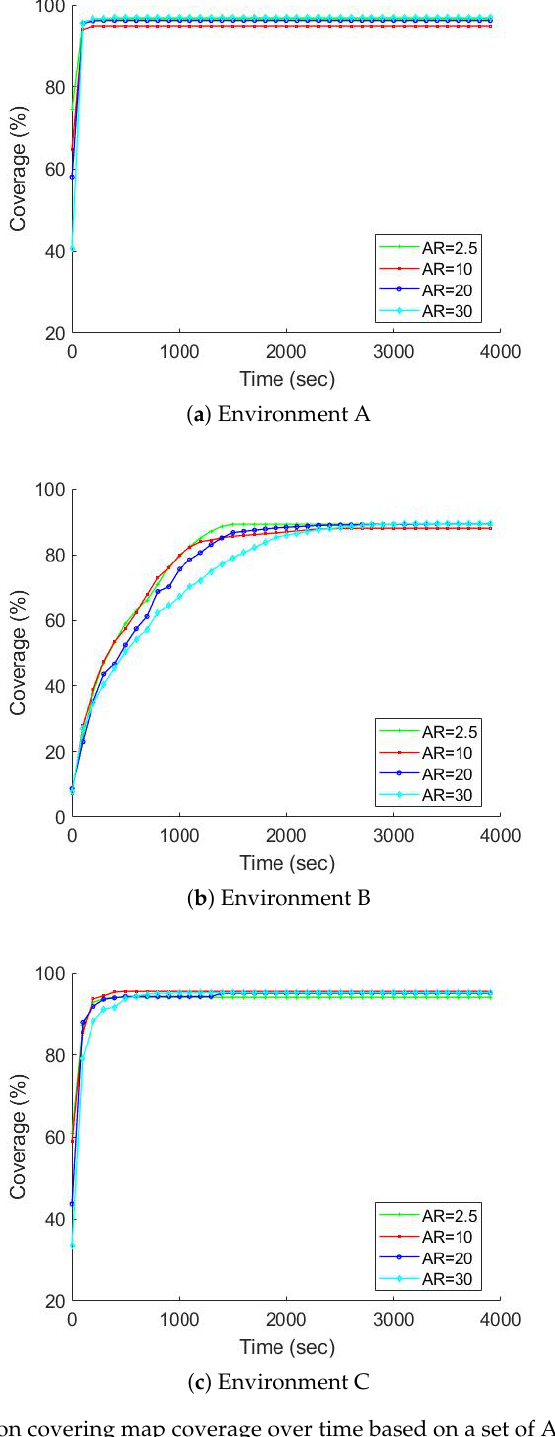
Figure 14. The radiation covering map coverage over time based on a set of AR, FOV is equal to 360 degrees, average over ten